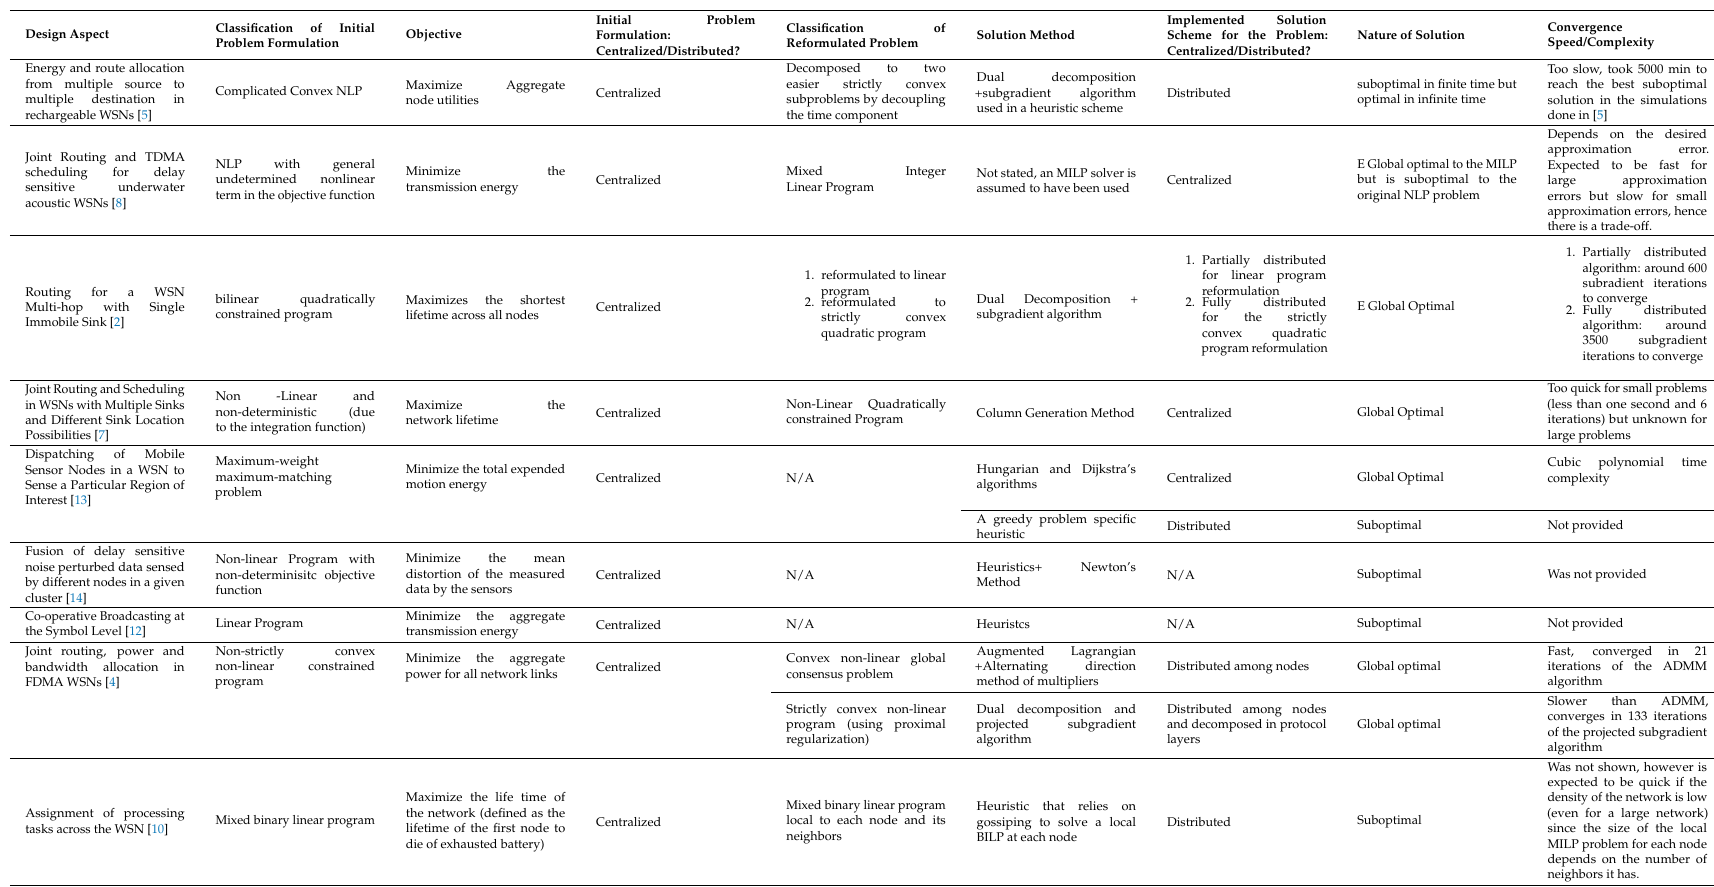
Table 3. Summary of the covered design problems and the corresponding optimization